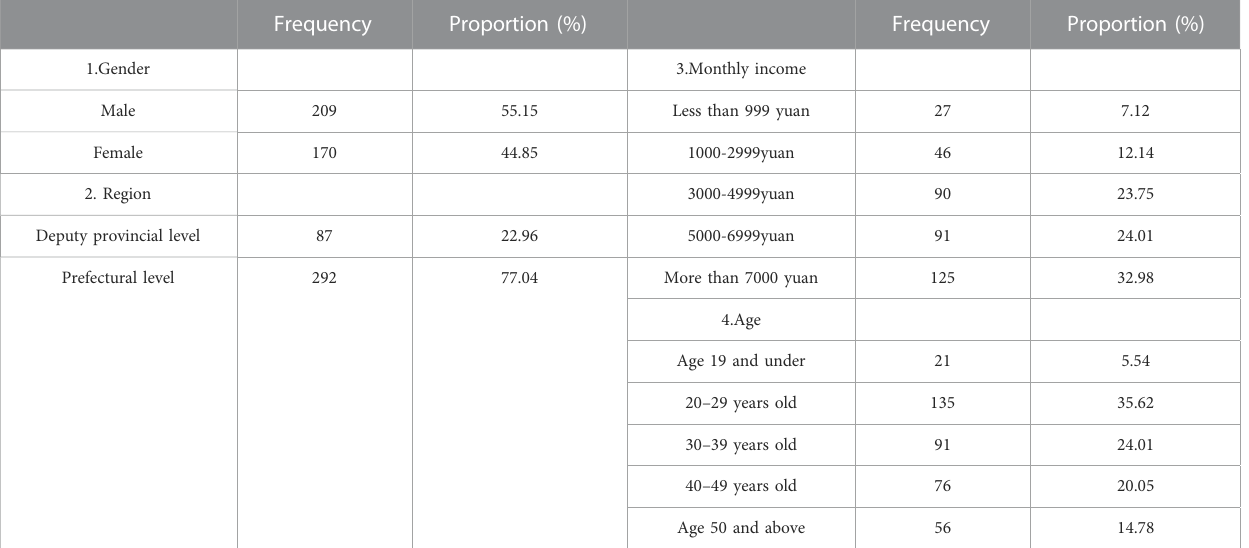
TABLE 2 Sample attributes of the questionnaire.